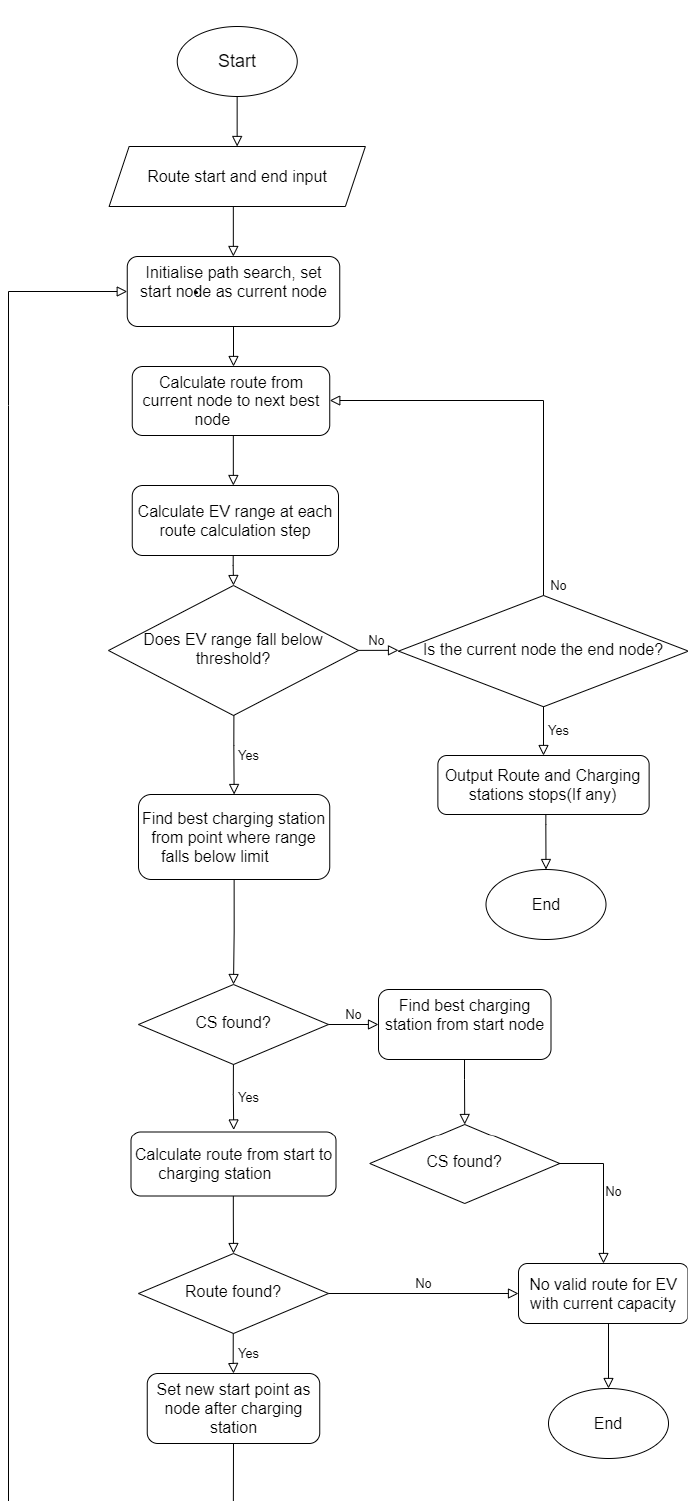
Figure 2. Flowchart illustrating the main steps of our detour computation